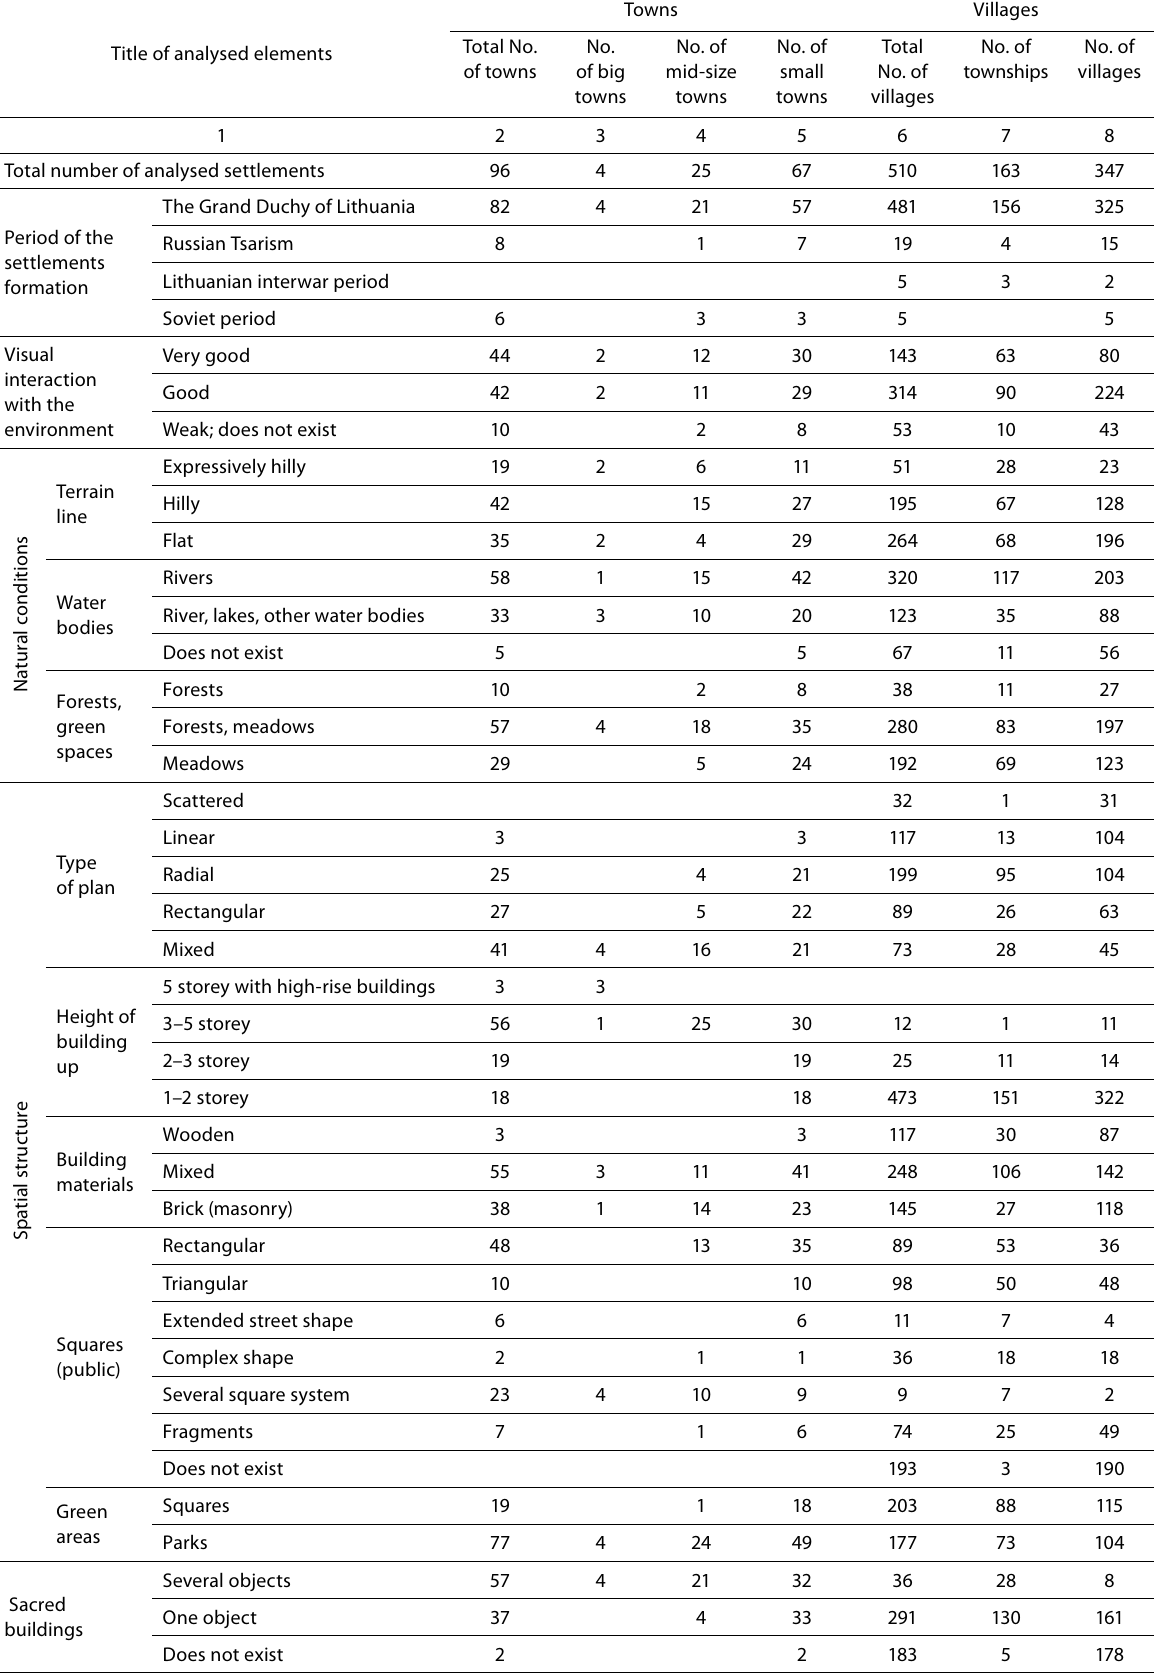
Table 1. The results of the analysis of the spatial structural features of the lithuanian cities, towns, townships and villages